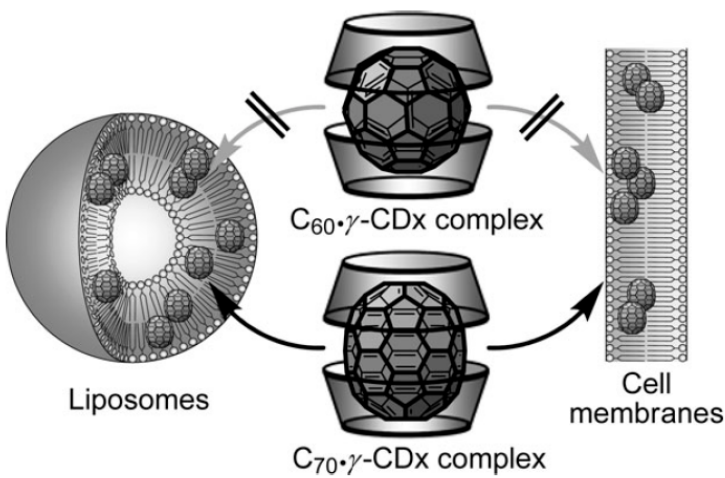
Figure 1. A sketch of the possible insertion of C 70 (but not of C 60 ) from the γ -CD complex into cell membranes or liposomes, as experimentally observed in [3]. Image reproduced with permission of Royal Society of Chemistry via the Copyright Clearance Center.